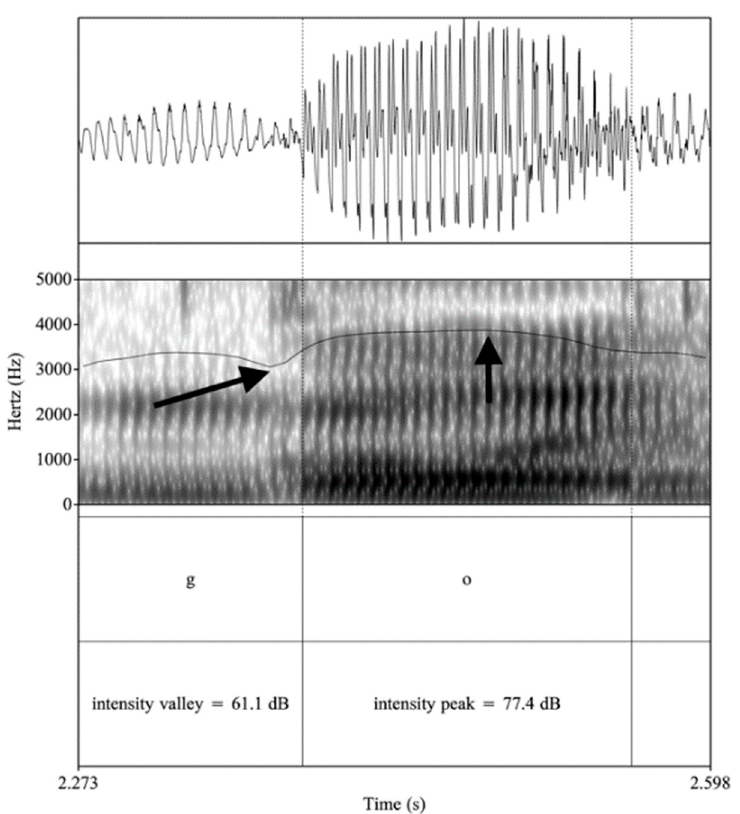
Figure 4. Spanish production of post-pausal, word-initial / ɡ / in gol ‘goal’.